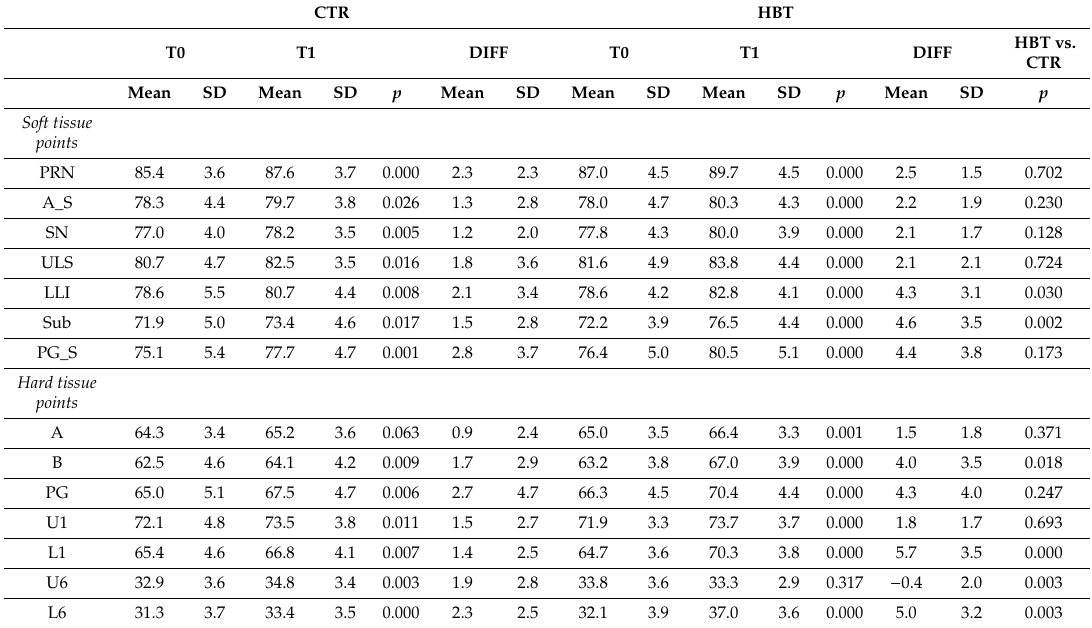
Table 1. Linear cephalometric measurement before (T0) and after (T1) the treatment / observation period. Data are reported as mean and standard deviation for patients treated with Herbst appliance (HBT) and controls (CTR) groups. Absolute cephalometric changes (T1–T0) are converted to relative changes over a 12-month period. The paired and unpaired t-test were used for the statistical analysis. The significance level was set at p < 0.05. The bold type indicates statistically significant di ff erences between